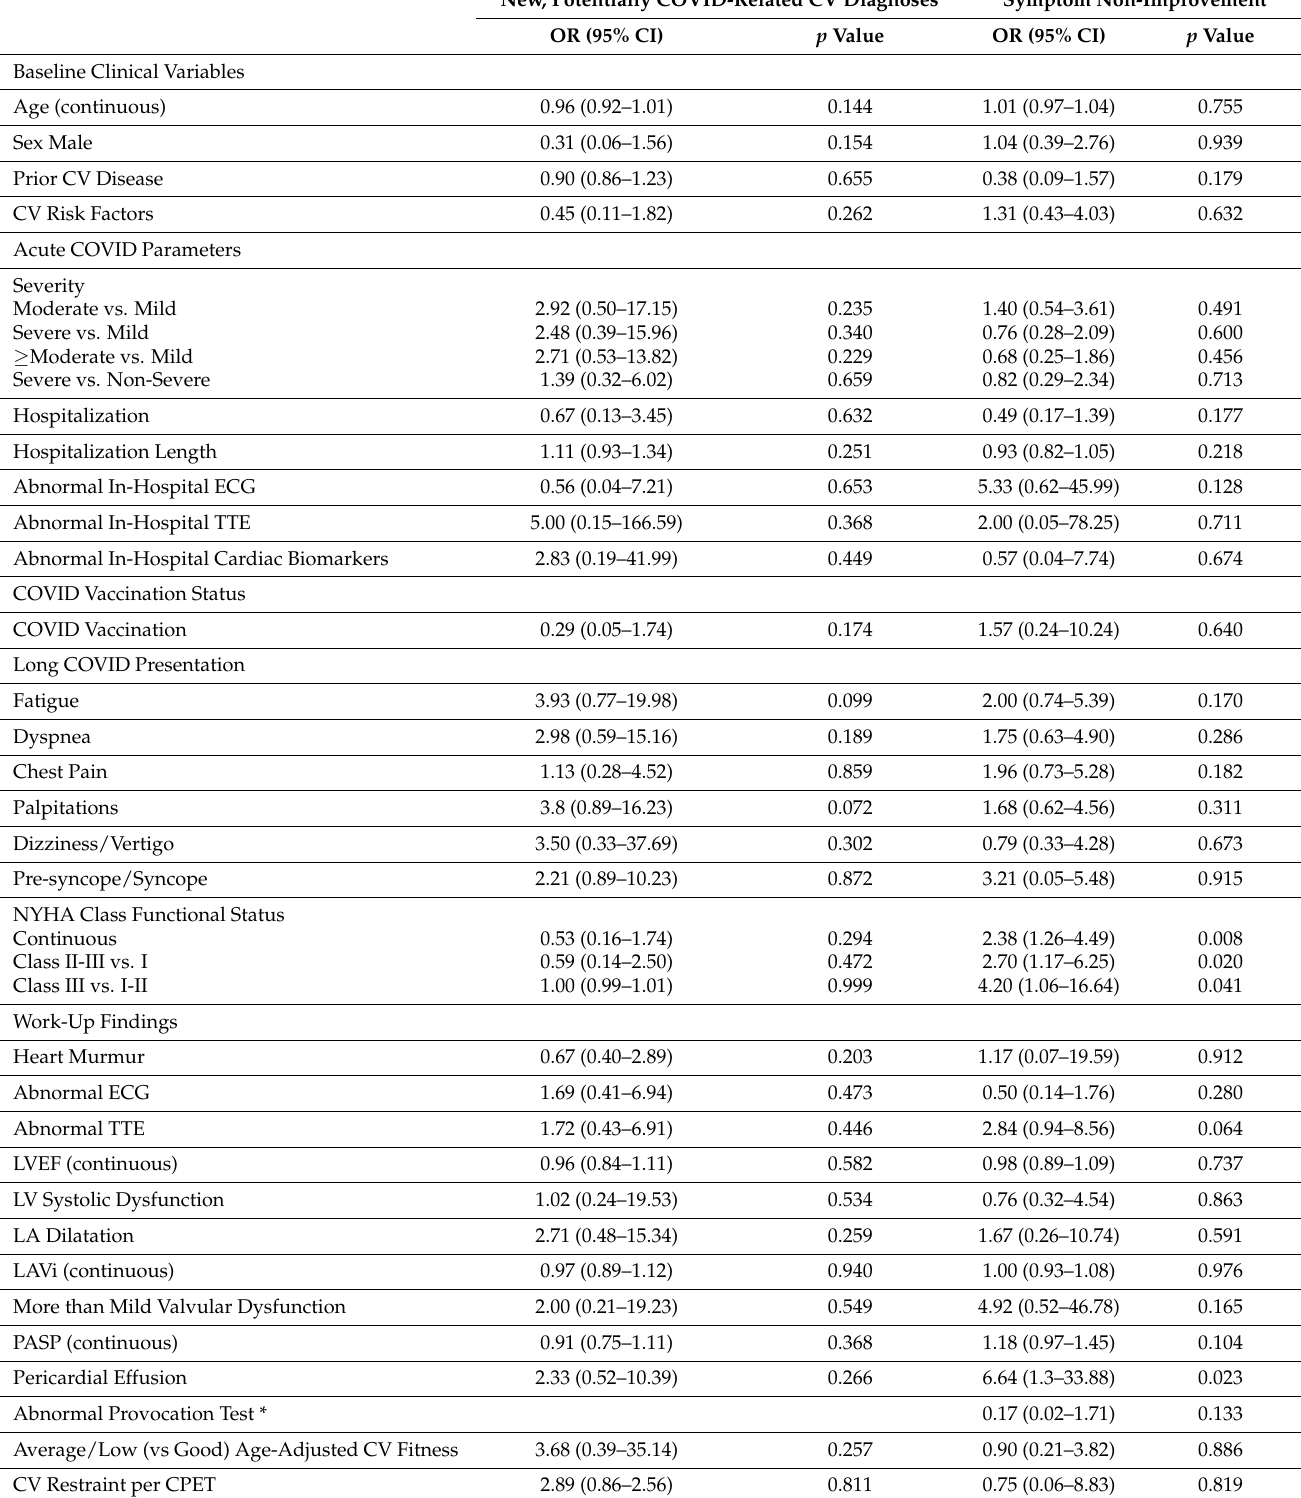
Table 5. Univariate binary logistic regression model for the outcomes of new, potentially COVID- related cardiovascular diagnoses and symptom